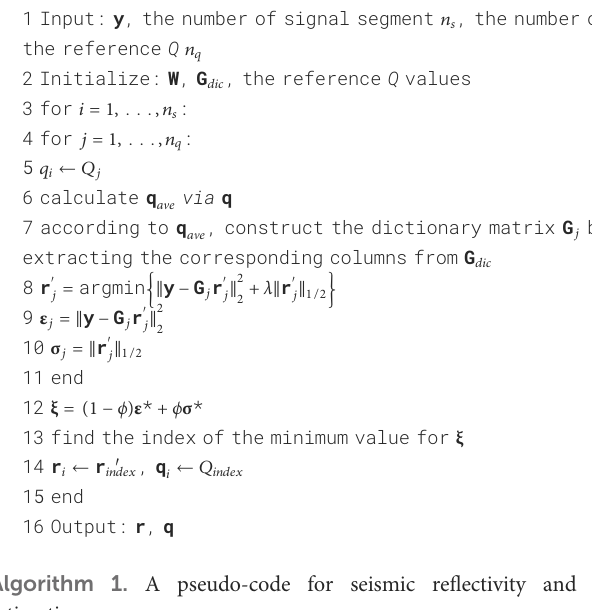
Algorithm 1. A pseudo-code for seismic re fl ectivity and Q estimation.